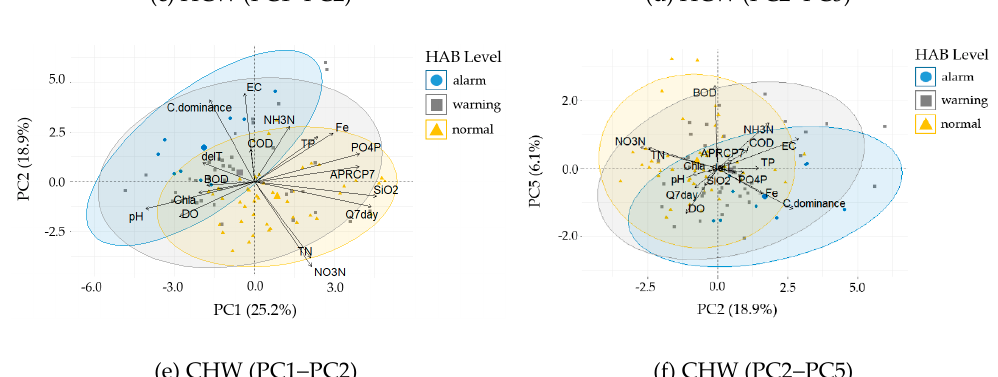
Figure 8. Principle component analysis (PCA) bi-plots grouped by the harmful algal bloom (HAB) level. The larger symbols indicate the group mean point for each HAB level. ( a ) Gangjeong Goryeong weir (GGW; PC1-PC2), ( b ) Dalseong weir (DSW; PC1-PC2), ( c ) Hapcheon Changnyeong weir (HCW; PC1-PC2), ( d ) HCW (PC2-PC5), ( e ) Changnyeong Haman weir (CHW: PC1-PC2), and ( f ) CHW (PC2- PC5). Table 4. Contributions of variables to principal components; Gangjeong Goryeong weir (GGW), Dalseong weir (DSW), Hapcheon Changnyeong weir (HCW), and Changnyeong Haman weir (CHW). Note: see the main text for definitions of abbreviated variables.